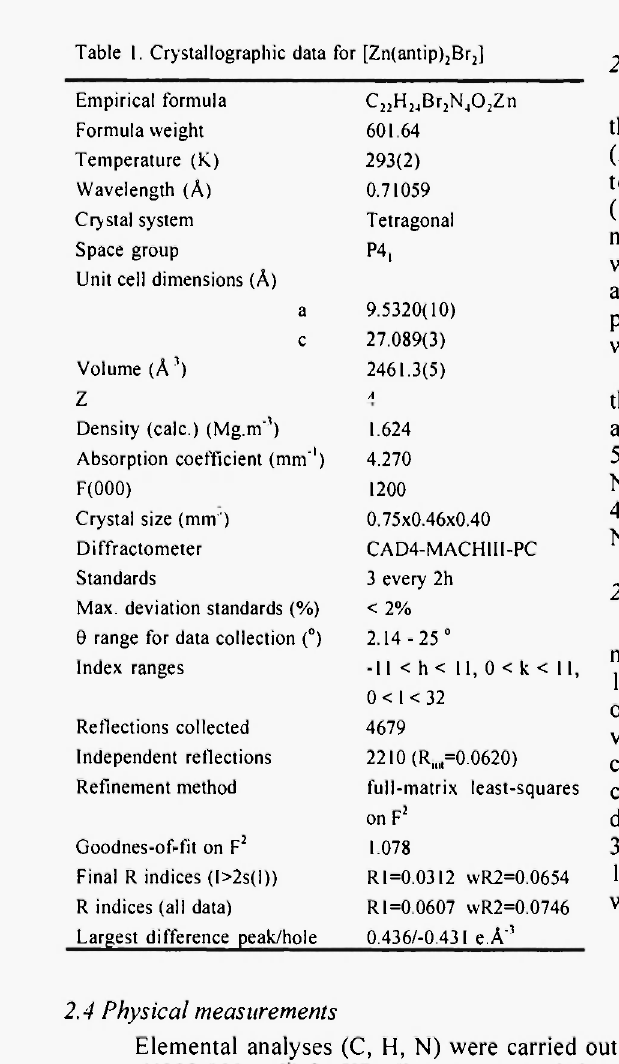
Table 1. Crystallographic data for [Zn(antip) 2 Br 2